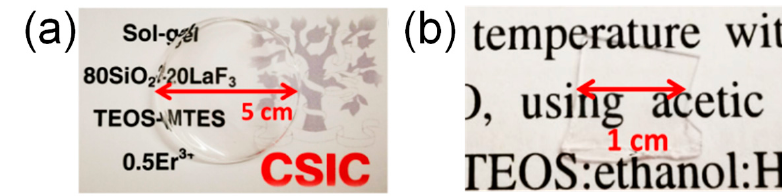
Figure 3. Differential thermal analysis (DTA, red) and thermogravimetry (TG, blue) curve for 80SiO 2 - 20LaF 3 -0.5Er 3+ (TEOS-MTES) bulk sample treated in the air with a heating rate of 10 ° C/min.